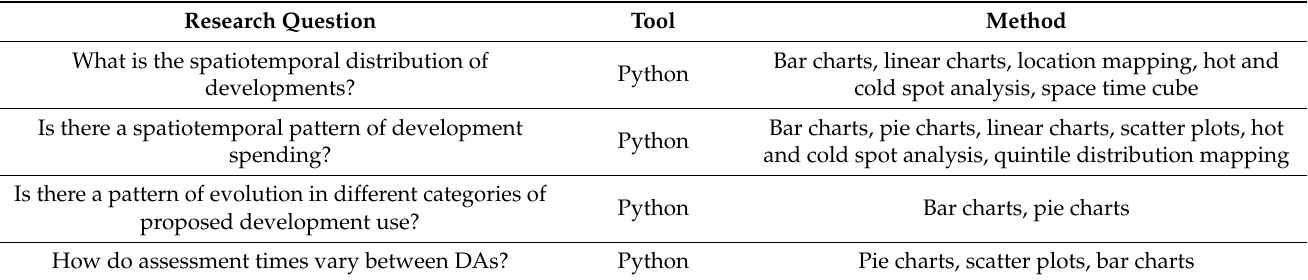
Table 1. Proposed methodology per research objective.